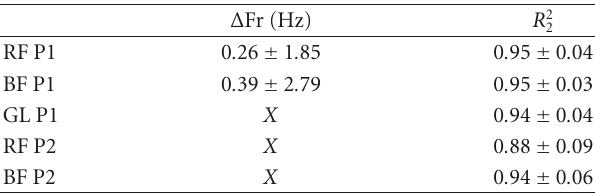
Table 2: Contra-lateral analysis: mean ±